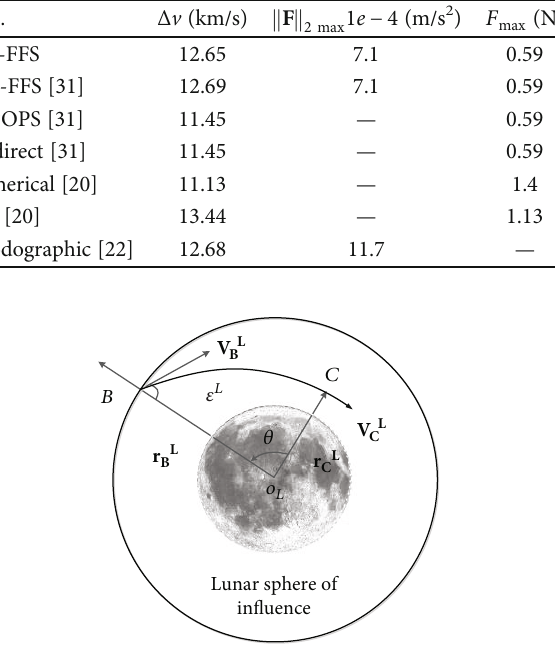
Figure 13: Diagram of the selenocentric